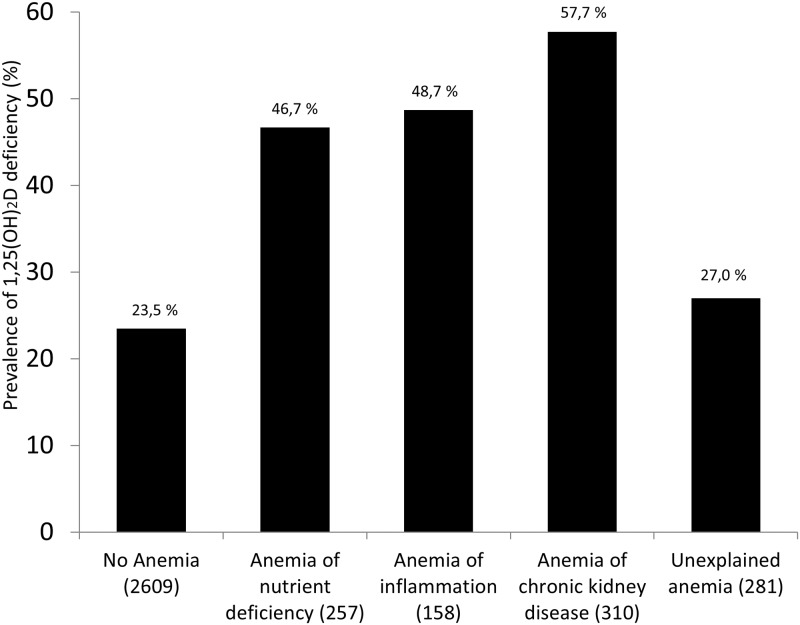
Prevalence of 1,25(OH)2D levels <40 pmol/l according to subtypes of anemia.There were significant differences between subgroups (P<0.001). Number of patients in brackets.